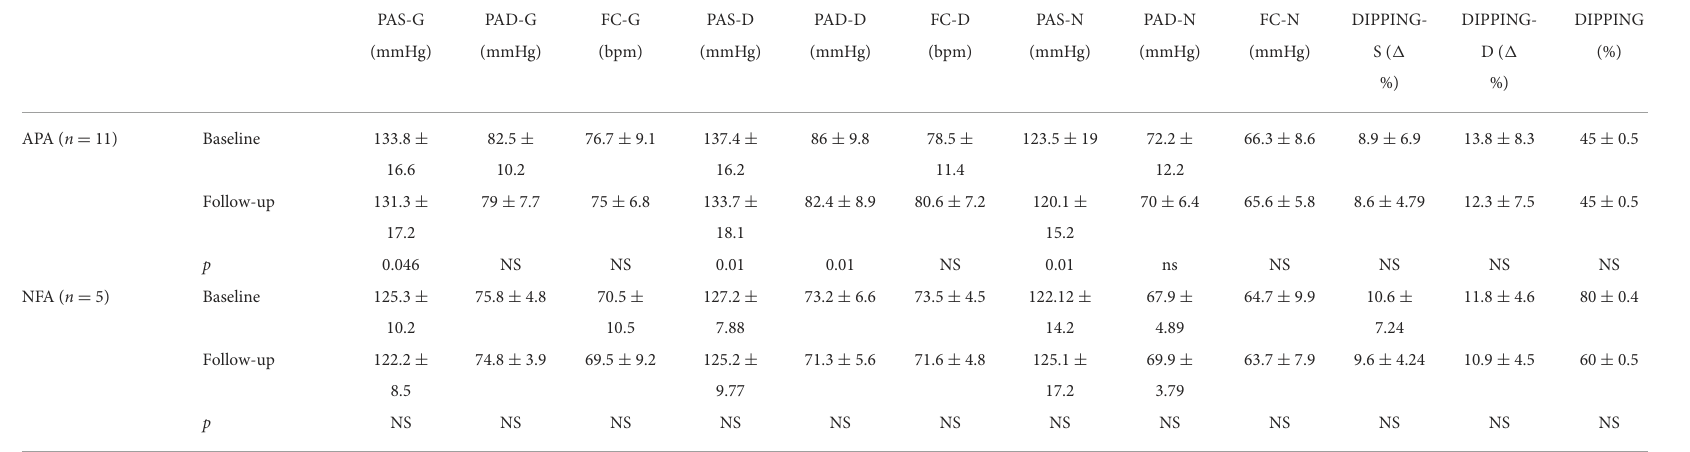
TABLE 3 Twenty-four-hour-ABPM data of all patients at baseline compared to follow-up.